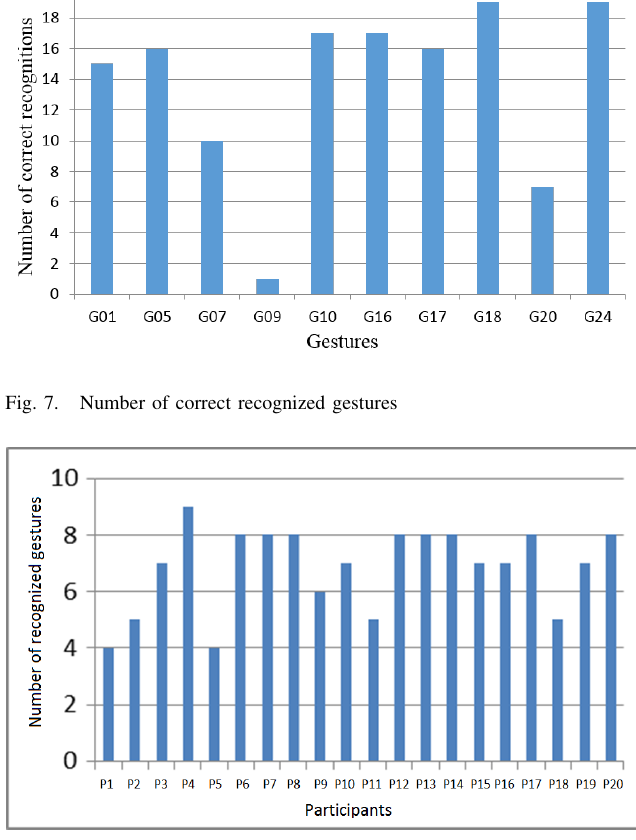
Fig. 8. Number of recognized gestures by